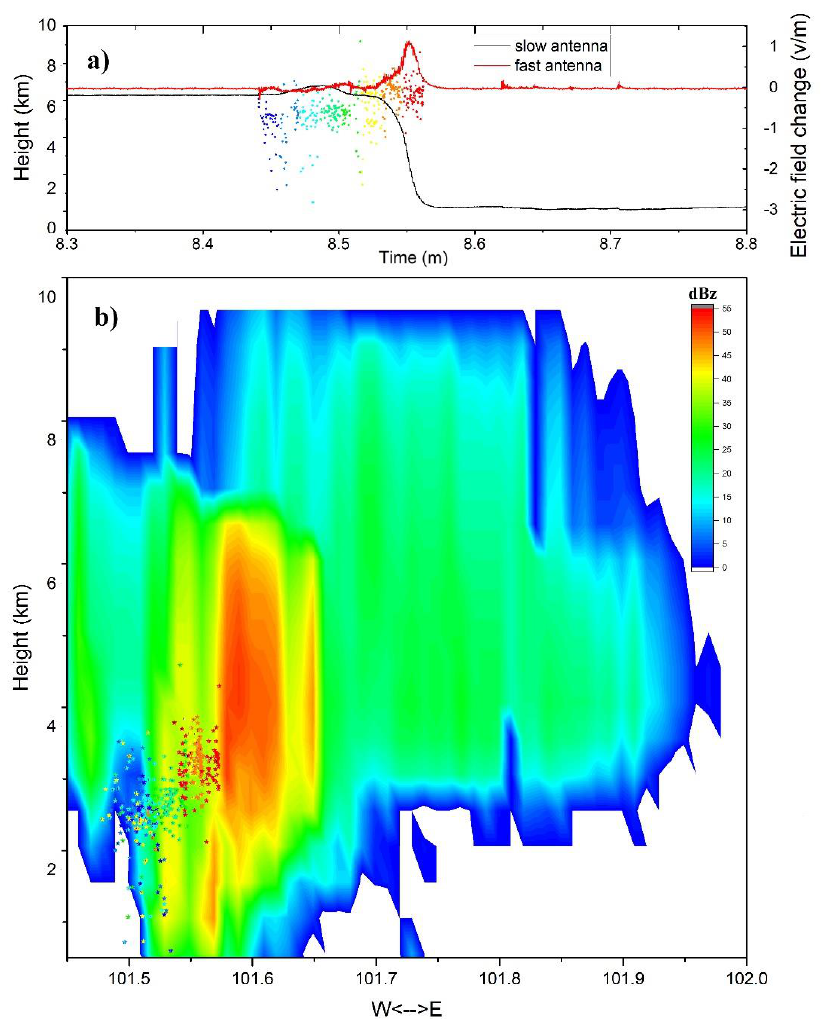
Figure 10. Fast and slow electric field change waveforms of positive ground flash No. 134708 and the positioning results of the VHF radiation sources compared with the radar echo. ( a ) Height-time plots and electric field change waveforms; ( b ) North-Southward vertical projection superimposed by vertical section of